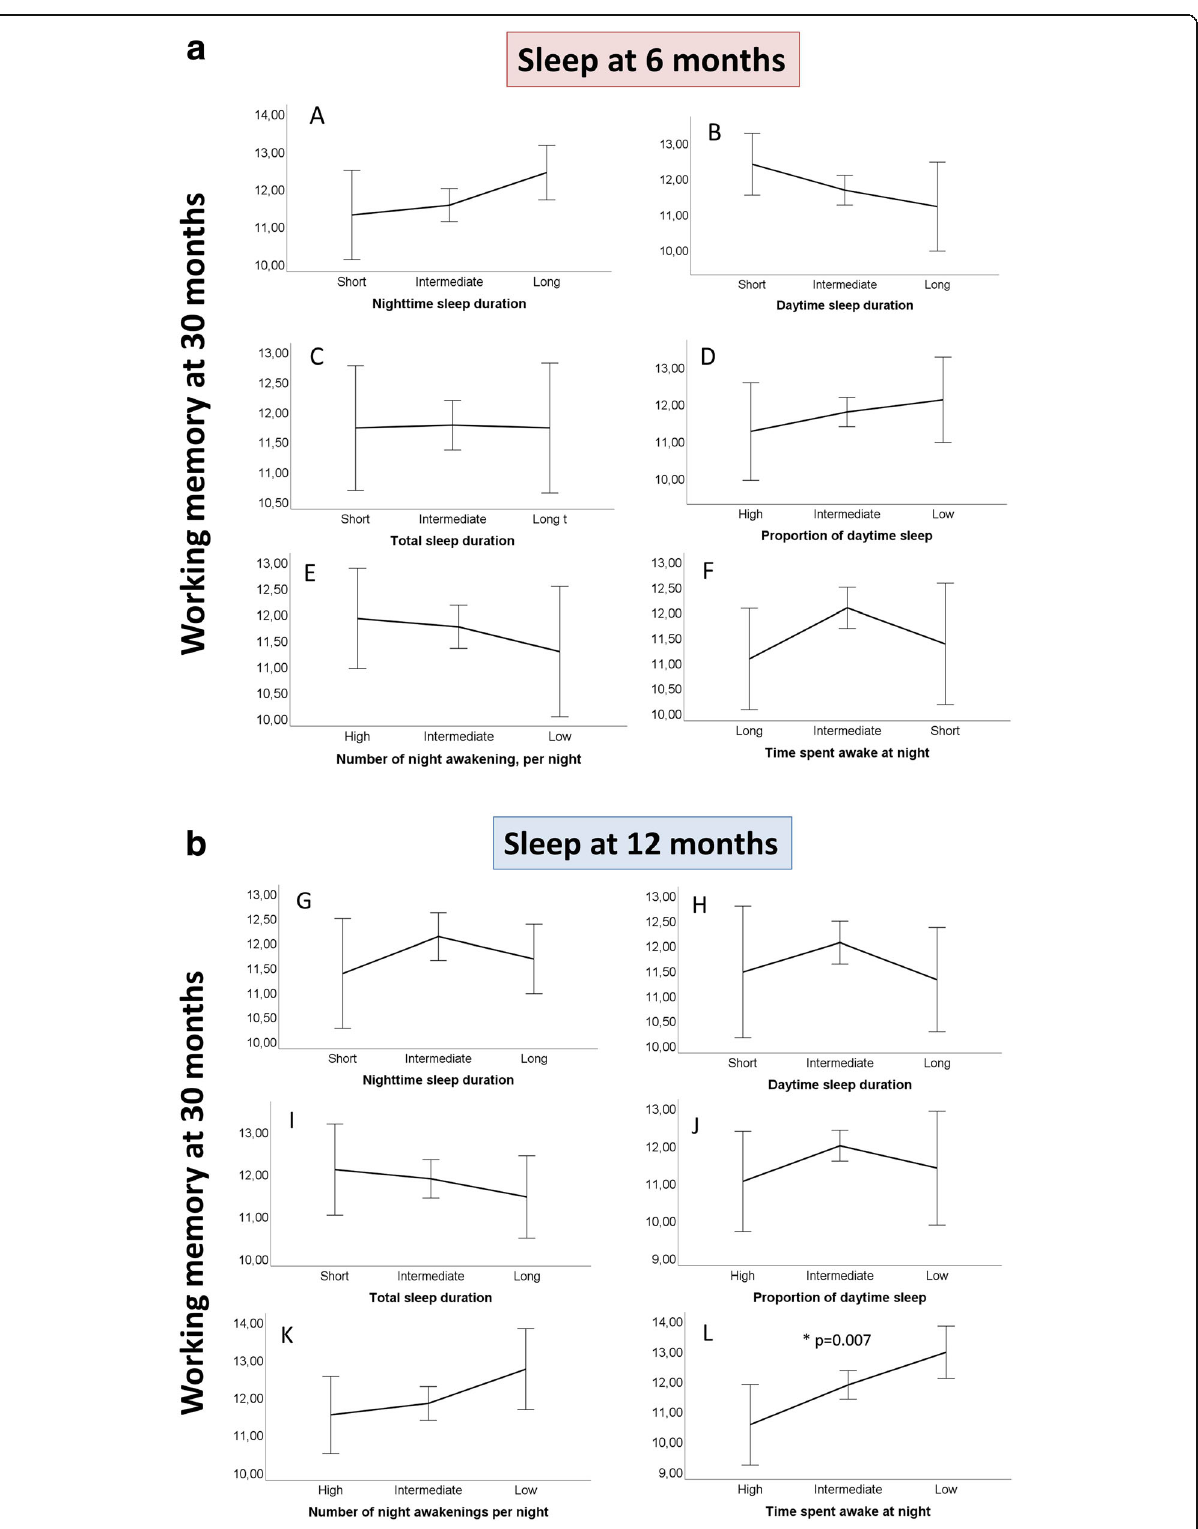
Fig. 3 (See legend on next